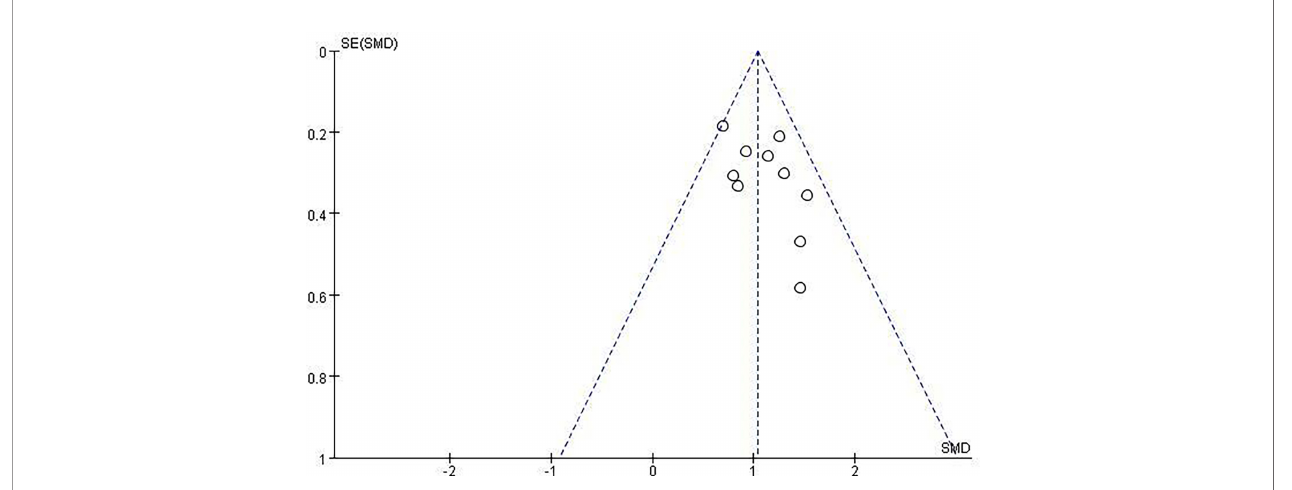
FIGURE 3 | Funnel plot of volume changes before and after thermal ablation.